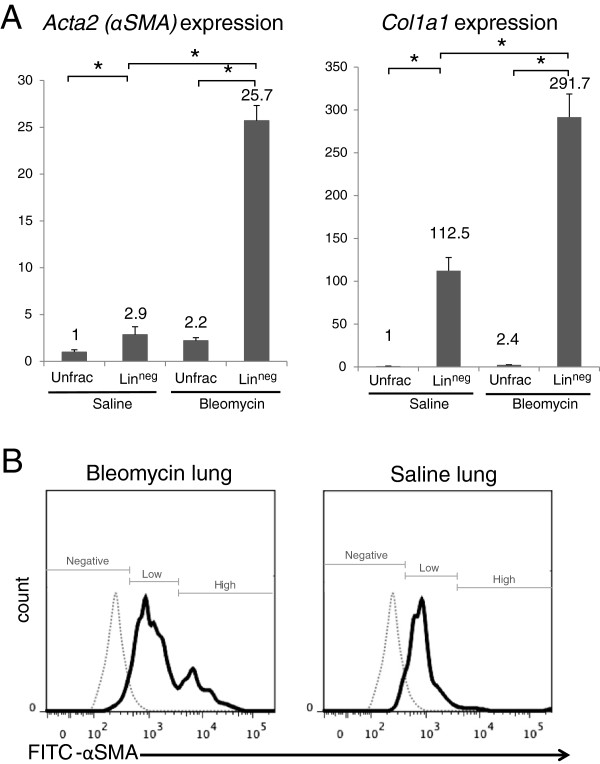
Myofibroblasts and fibroblasts were enriched in linneg cells of saline-treated lungs and bleomycin-injured lungs. (A) Expression levels of Acta2 and Col1a1mRNA were compared among unfractionated cells of saline-treated lungs, linneg cells of saline-treated lungs, unfractionated cells of bleomycin-injured lungs at day 12, and linneg cells of bleomycin-injured lungs at day 12 using qRT-PCR. Results were normalized to expression levels of unfractionated cells of saline-treated lungs. QRT-PCR was performed in triplicate using three independently prepared RNA samples. Results represent the mean (± s.d.) of three experiments. *, P < 0.01. (B) Expression levels of intracellular α-SMA were compared between linneg cells of bleomycin-injured lungs at day 12 (left) and linneg cells of saline-treated lungs (right) using FITC-conjugated anti-α-SMA antibody. As shown in Figure 
2C, 10,000 sorted linneg cells were fixed in 10% formalin and then permeabilized and incubated with mouse FITC-conjugated isotype control antibody (IgG2a) or FITC-conjugated anti-α-SMA antibody. The fluorescence intensity of FITC-α-SMA (black line) or FITC-conjugated isotype control (gray line) of linneg cells is shown. Figures show representative results. Unfrac, unfractionated; s.d., standard deviation.